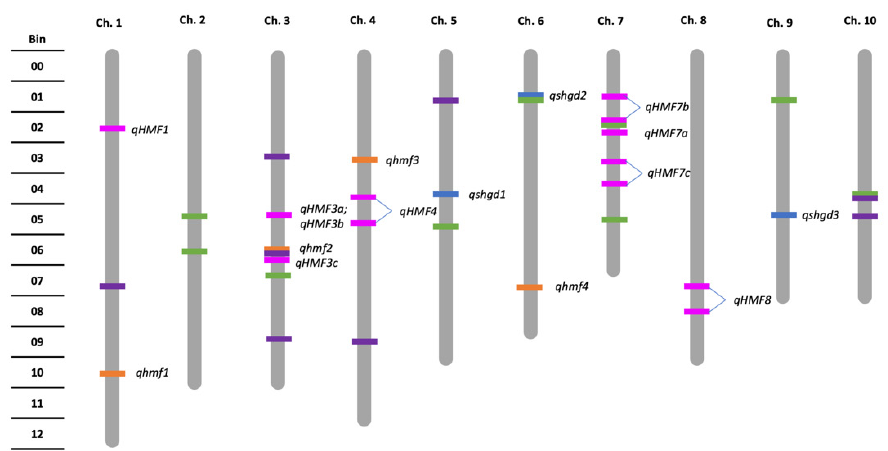
Figure 2. Genetic map showing location of quantitative trait loci (QTL) contributing to spontaneous haploid genome doubling (SHGD) from Ren et al. [23] (orange, lowercase hmf ), Ren et al. and Trampe et al. [21,22] (blue), Yang et al. [38] (pink, uppercase HMF ) and SNPs contributing to SHGD from Chaikam et al. [34] (green), and from Ma et al. [33] (purple). Map length depicted is from Ren et al. [23], totaling 1484.5 cM.